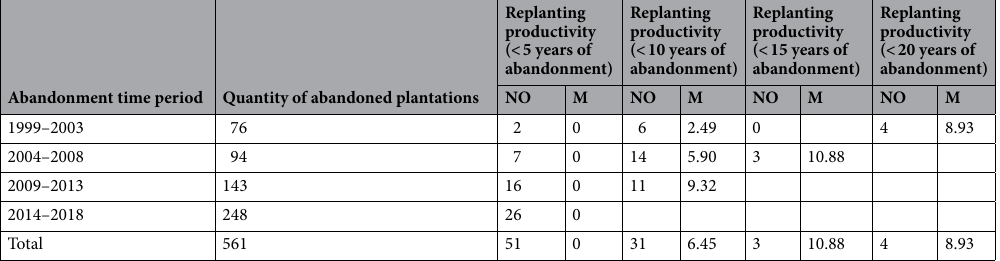
Table 11. Productivity of plantations that have replanted